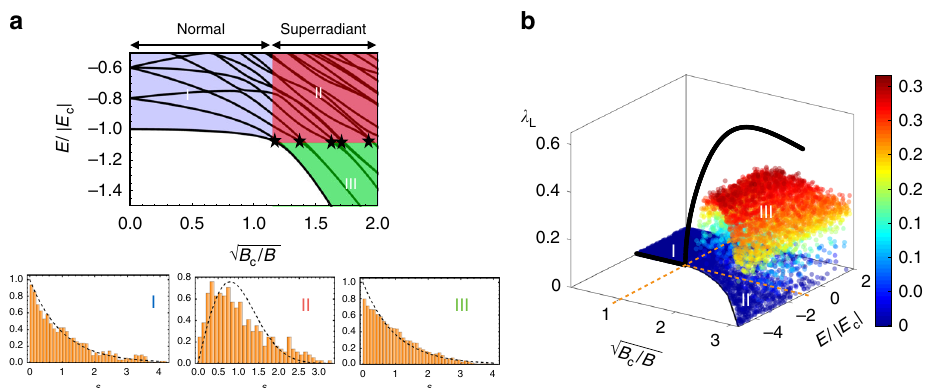
Fig. 2 Characterization of classical and quantum chaos in the Dicke model. a Phase diagram of the Dicke model. At zero temperature it exhibits a quantum phase transition between a normal to a superradiant phase, at B = B c . A line of excited energy quantum phase transitions (ESQPTs) occurs at the critical energy E c = − BN /2, signaled by singularities in the energy level structure (indicated by stars). Note that for fi gure clarity we have used a small system N = 20 resulting in the small deviation of the ESQPTs from E c = − BN /2. The ESQPTs are accompanied by a change in the level statistics which we denote by (I) − (III) (note that no eigenstates exist in the unlabeled white region). For (II) and (III) the spectrum is divided into low and high energy parts, separated by the ESQPT at E = E c , from which the statistics P ( s ), where s is the level spacing, are computed separately. (I) exhibits Poissonian statistics (regular regime), while (II) displays statistics similar to a Wigner − Dyson distribution indicative of level repulsion and quantum chaos, and (III) exhibits a mixture of both. The numerical parameters are g /(2 π ) = 0.66 kHz and δ /(2 π ) = 0.5 kHz. b Lyapunov exponents for the mean- fi eld dynamics of an ensemble of random states sorted by normalized mean- fi eld energy E /| E c | with E c = − BN /2, as a function of the fi eld between regular ( B > B c ) and chaotic dynamics ( B < B c ) characterized by λ ’ 0 and λ L > 0 respectively, occurs at B = B c . For B > B c and energies E ≲ E dynamics becomes increasingly regular. Source data are provided as a Source Data fi le